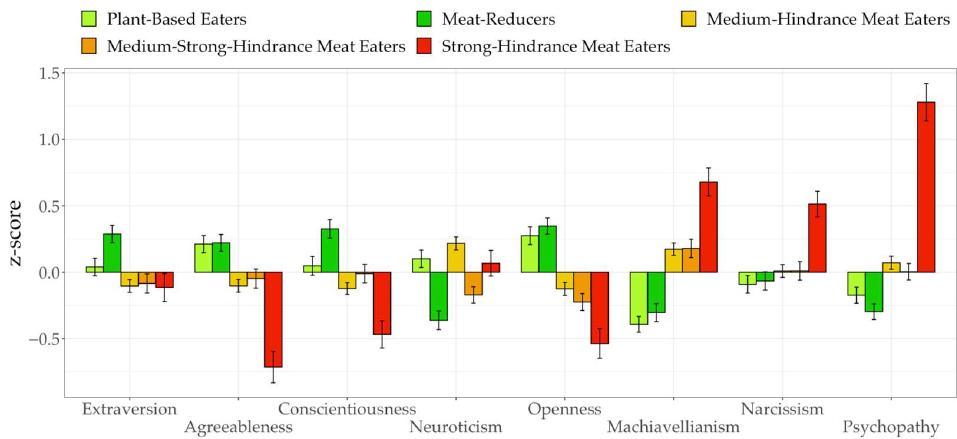
Figure 3. Mean differences in personality between profiles .